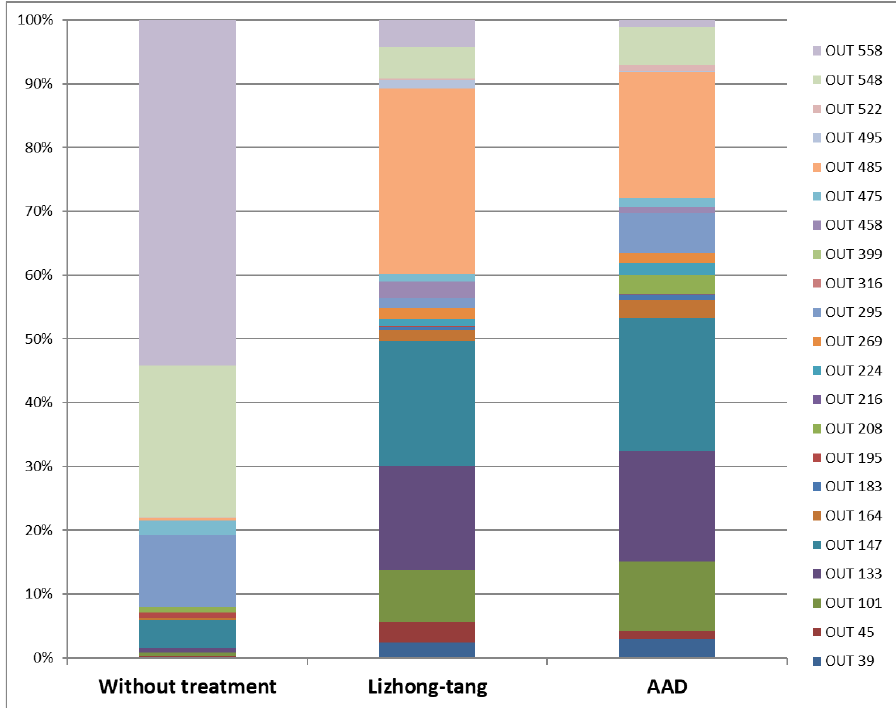
Figure 6. Principal component analysis showing the difference in the small intestinal microbiota composition between groups. Black dot: normal group, without treatment. Blue dot: control group, with antibiotic-associated diarrhea (AAD). Red dot: sample group, Lizhong-tang -administered group, post-AAD establishment.